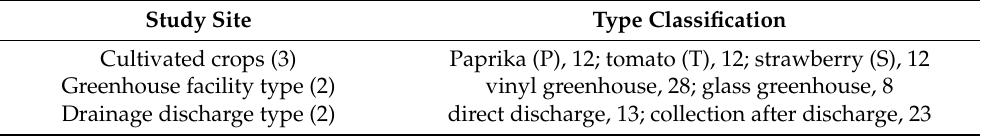
Table 1. Criteria for the selection of study